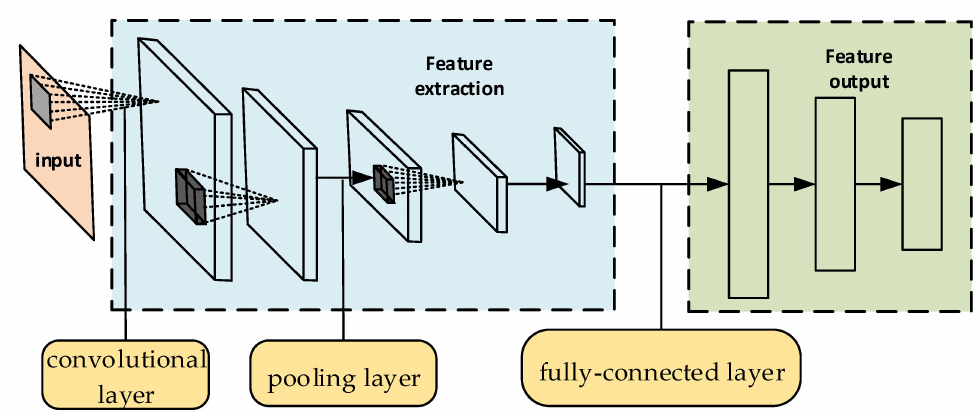
Figure 3. Schematic diagram of the CNN